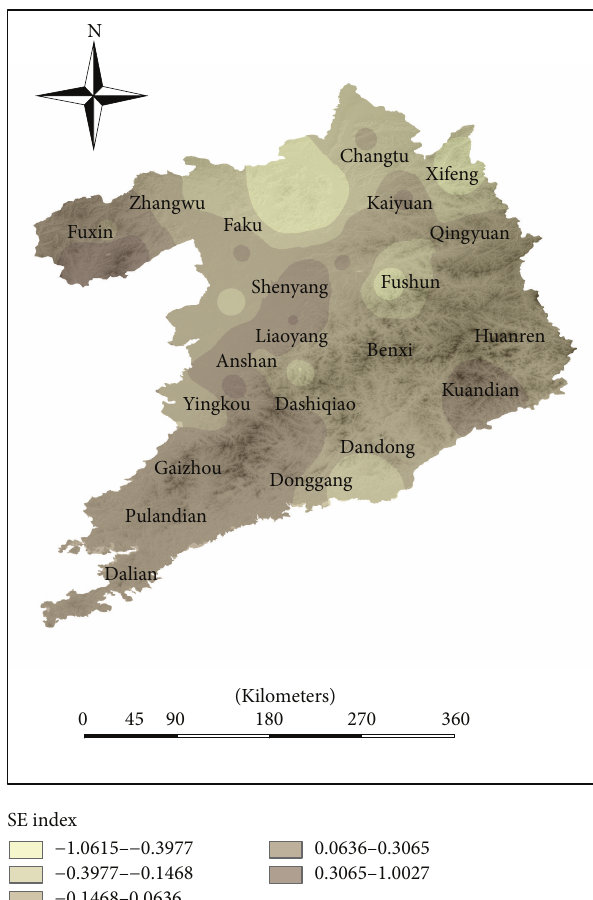
Figure 8: The distribution of natural environmental evaluation (NEE) index in Shenyang-Dalian urban agglomeration.